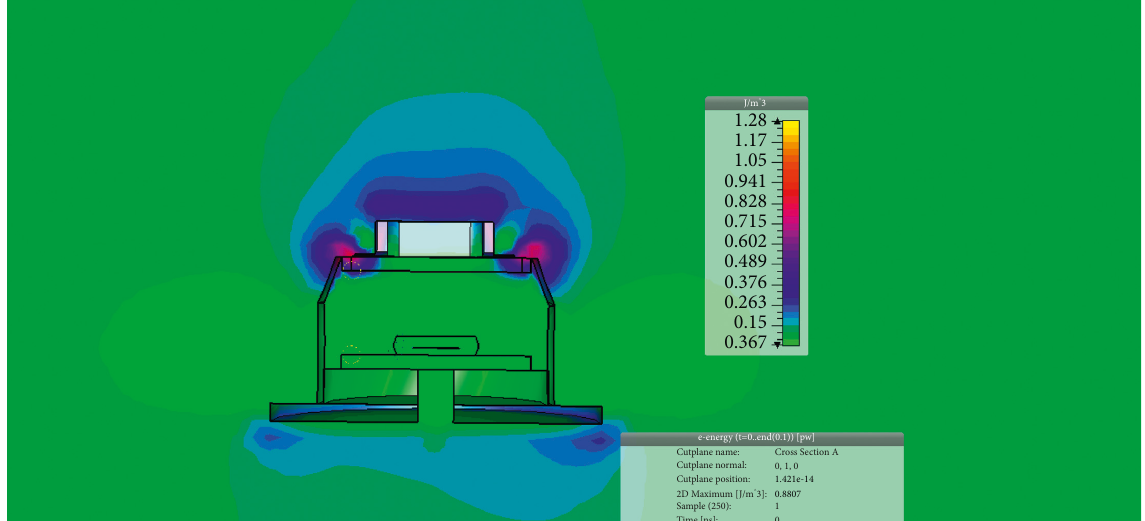
Figure 11: Electric field distribution inside the detector.